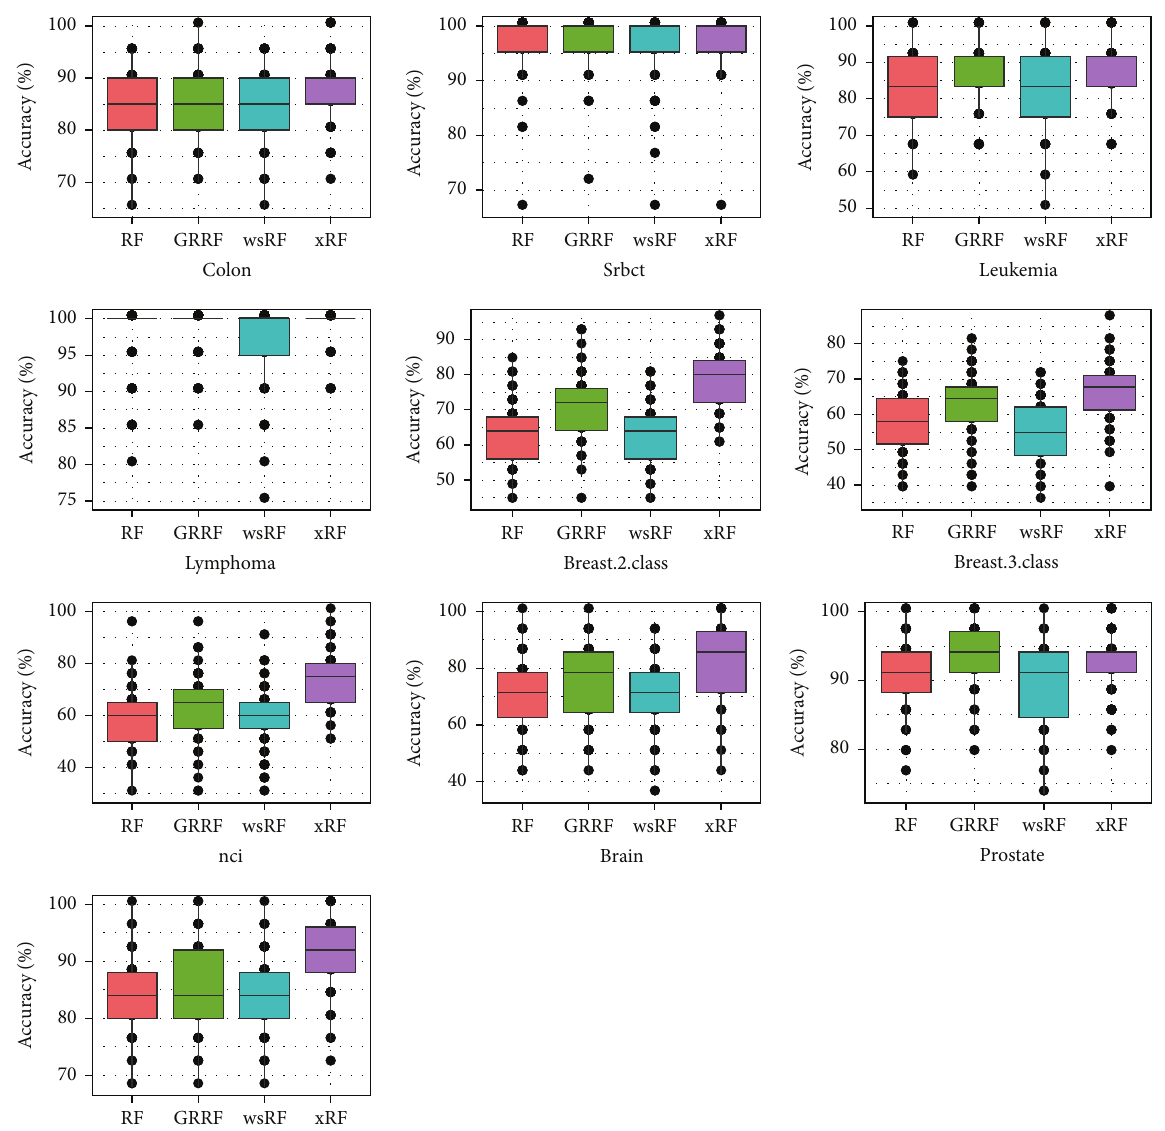
Figure 7: Box plots of test accuracy of the models on the ten gene